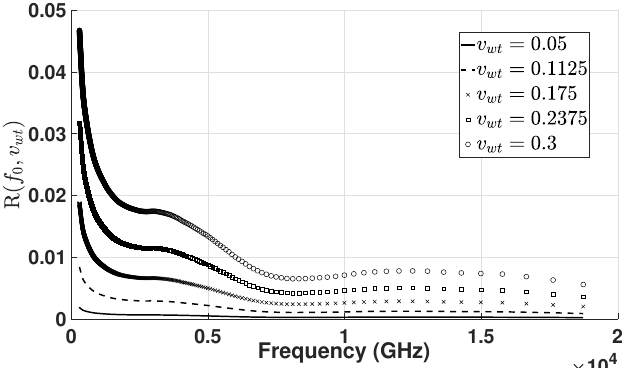
Figure 6. THz reflectance as a function of frequency between 300 GHz to 20 THz and v wt between 0.05 and